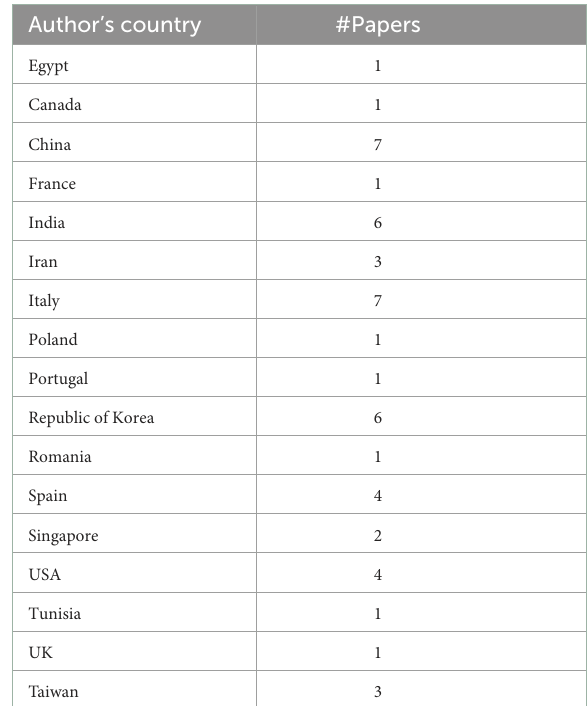
TABLE 4 Author’s